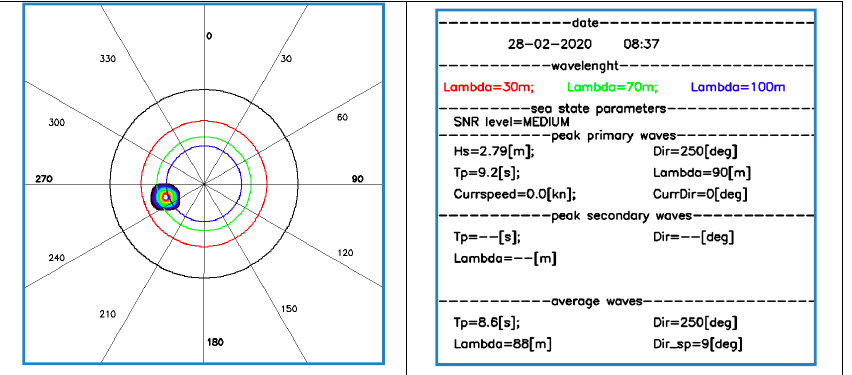
Figure 4. Directional spectra (on the left ) and wave parameter measurements (on the right ) from 26